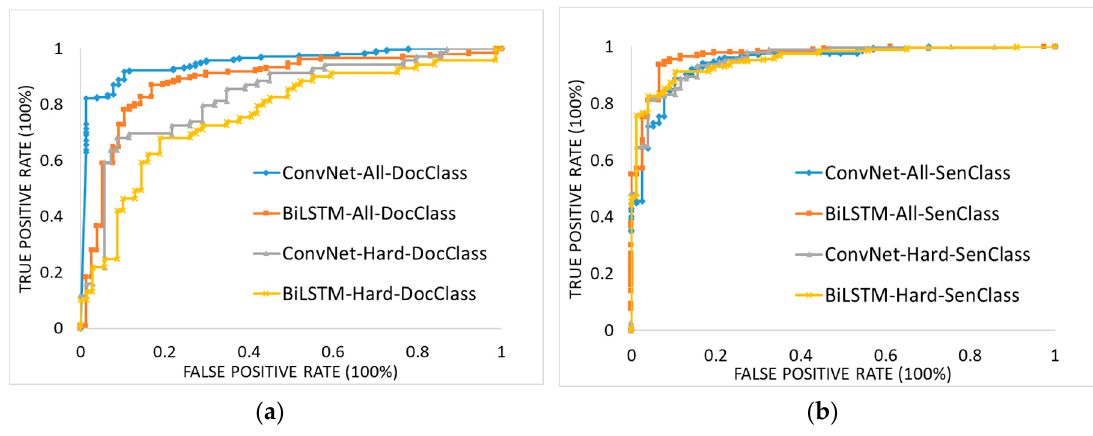
Figure 4. Receiver operating characteristic (ROC) curves of models classifying infectious disease occurrences: ( a ) ROC curves using DocClass for ConvNet and BiLSTM models and ( b ) ROC curves using SenClass for ConvNet and BiLSTM models.